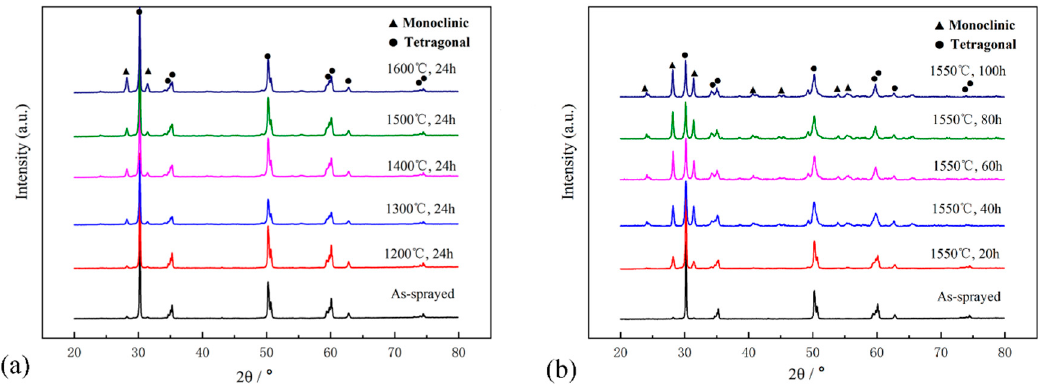
Figure 7. XRD patterns of the as-sprayed coating and heat-treated coatings: ( a ) samples after heat-treatment for 24 h at different temperatures; ( b ) samples after heat-treatment at 1550 °C for different times.